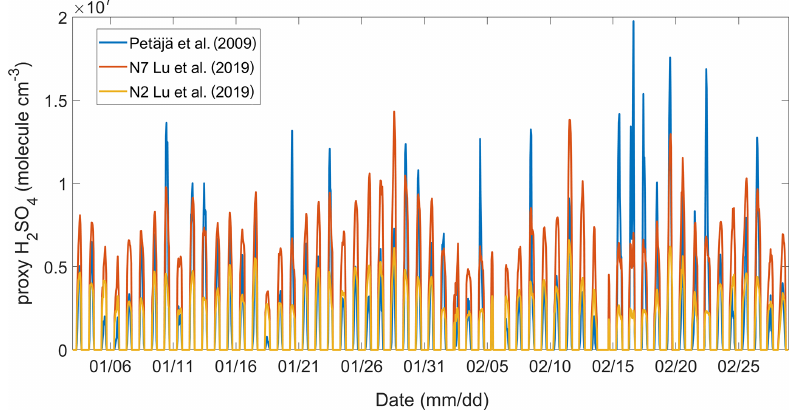
Figure 6. The sulfuric acid concentrations derived by different proxy equations. The red and orange lines indicate the result of the N2 and N7 methods by Lu et al. (2019), and the blue line indicates the calculation result based on the method recommended by Petäjä et al.